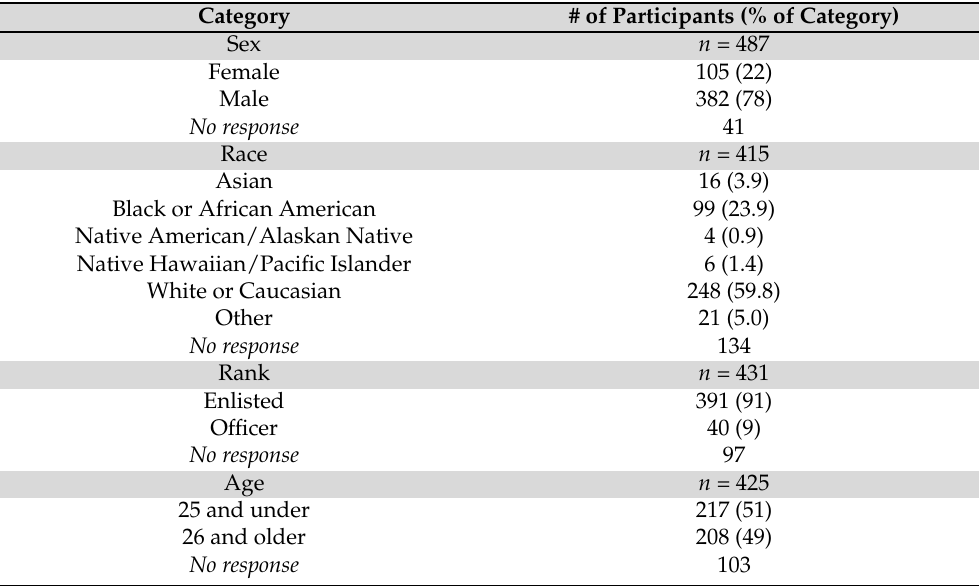
Table 3. Demographics of the US Army soldier cohort ( n =